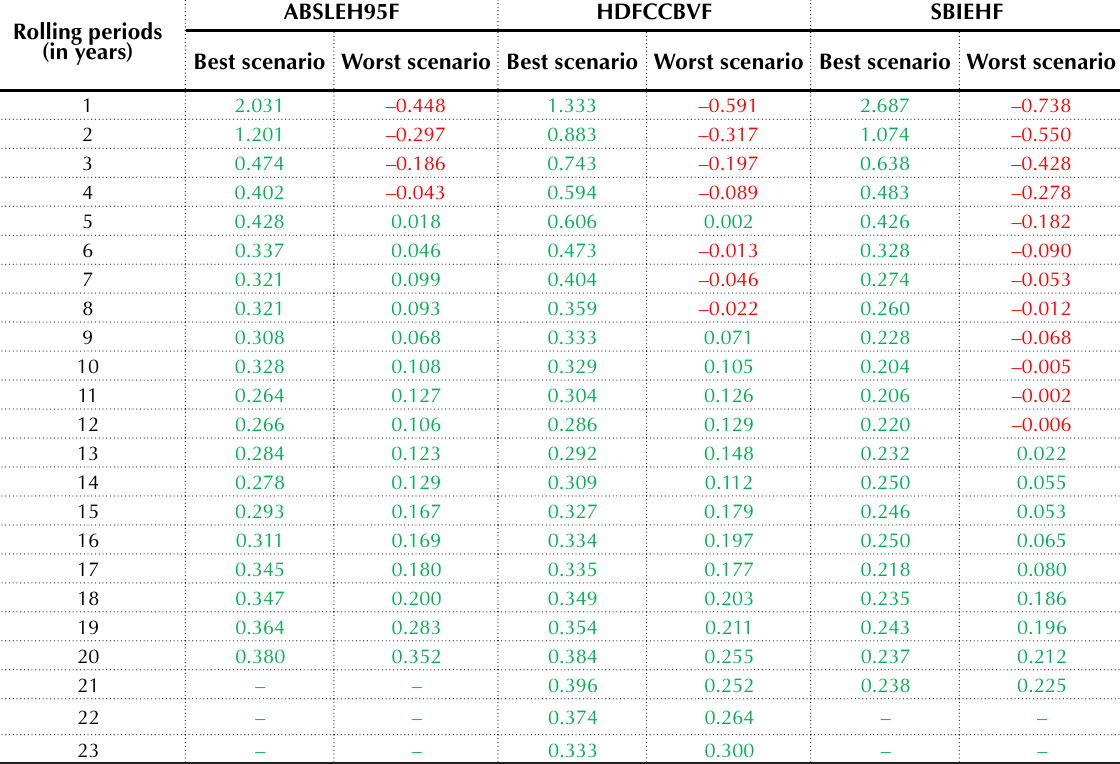
Table 5. Rolling period CAGR (in %) for ABSLEH95F, HDFCCBVF and SBIEHF schemes (from 1995 to